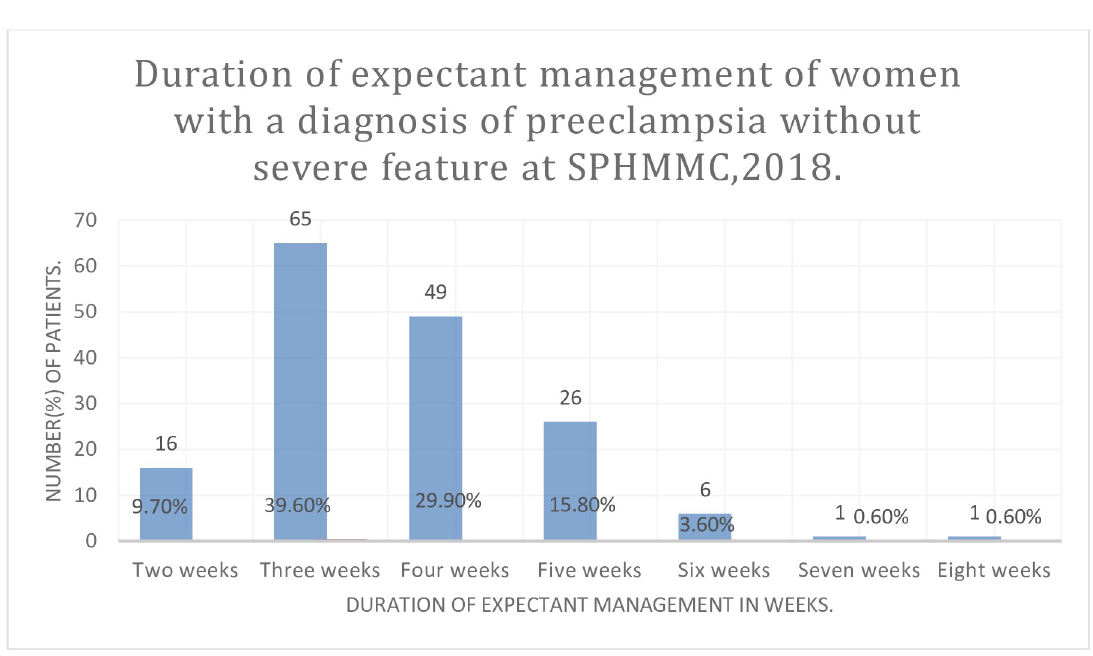
Fig 1. Duration of expectant management of women with a diagnosis of preeclampsia without severe feature at SPHMMC, 2018.